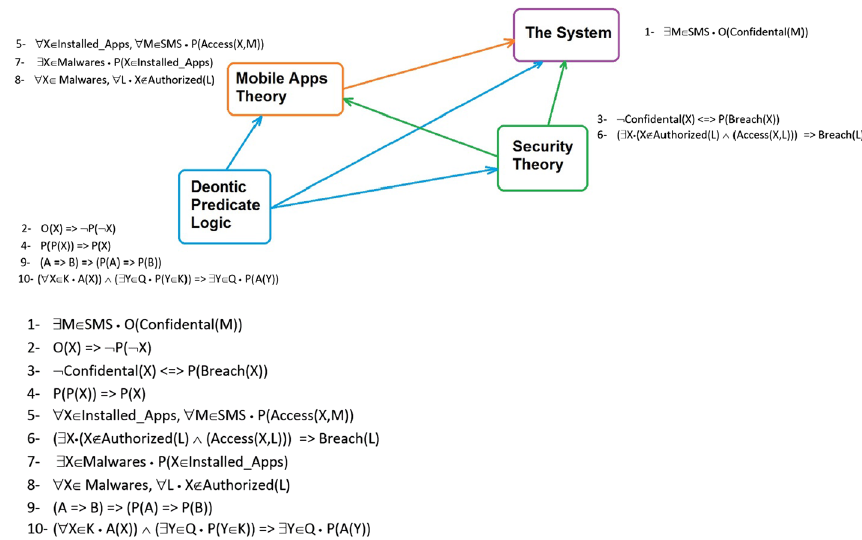
Fig. 4 The involving semantic theories and the semantic logic for Example 2